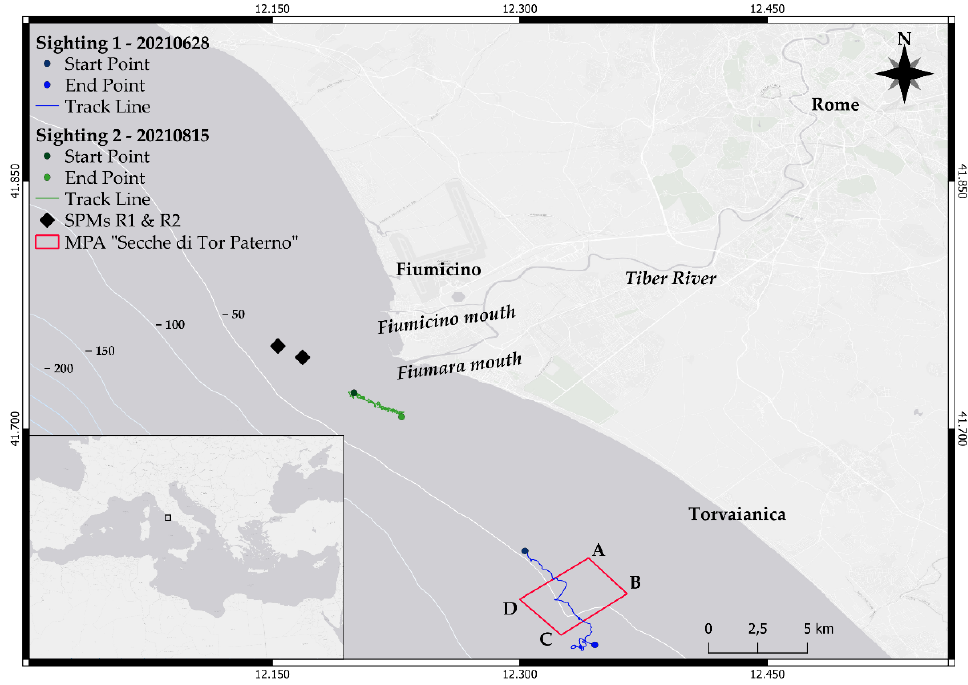
Figure 1. Map of the study site. The red rectangle represents the marine protected area “Secche di Tor Paterno” while the two diamonds represent the Single Point Moorings R1 and R2. The map also shows start and ending points (dots) and tracks (lines) of the first (blue) and the second (green) sighting.